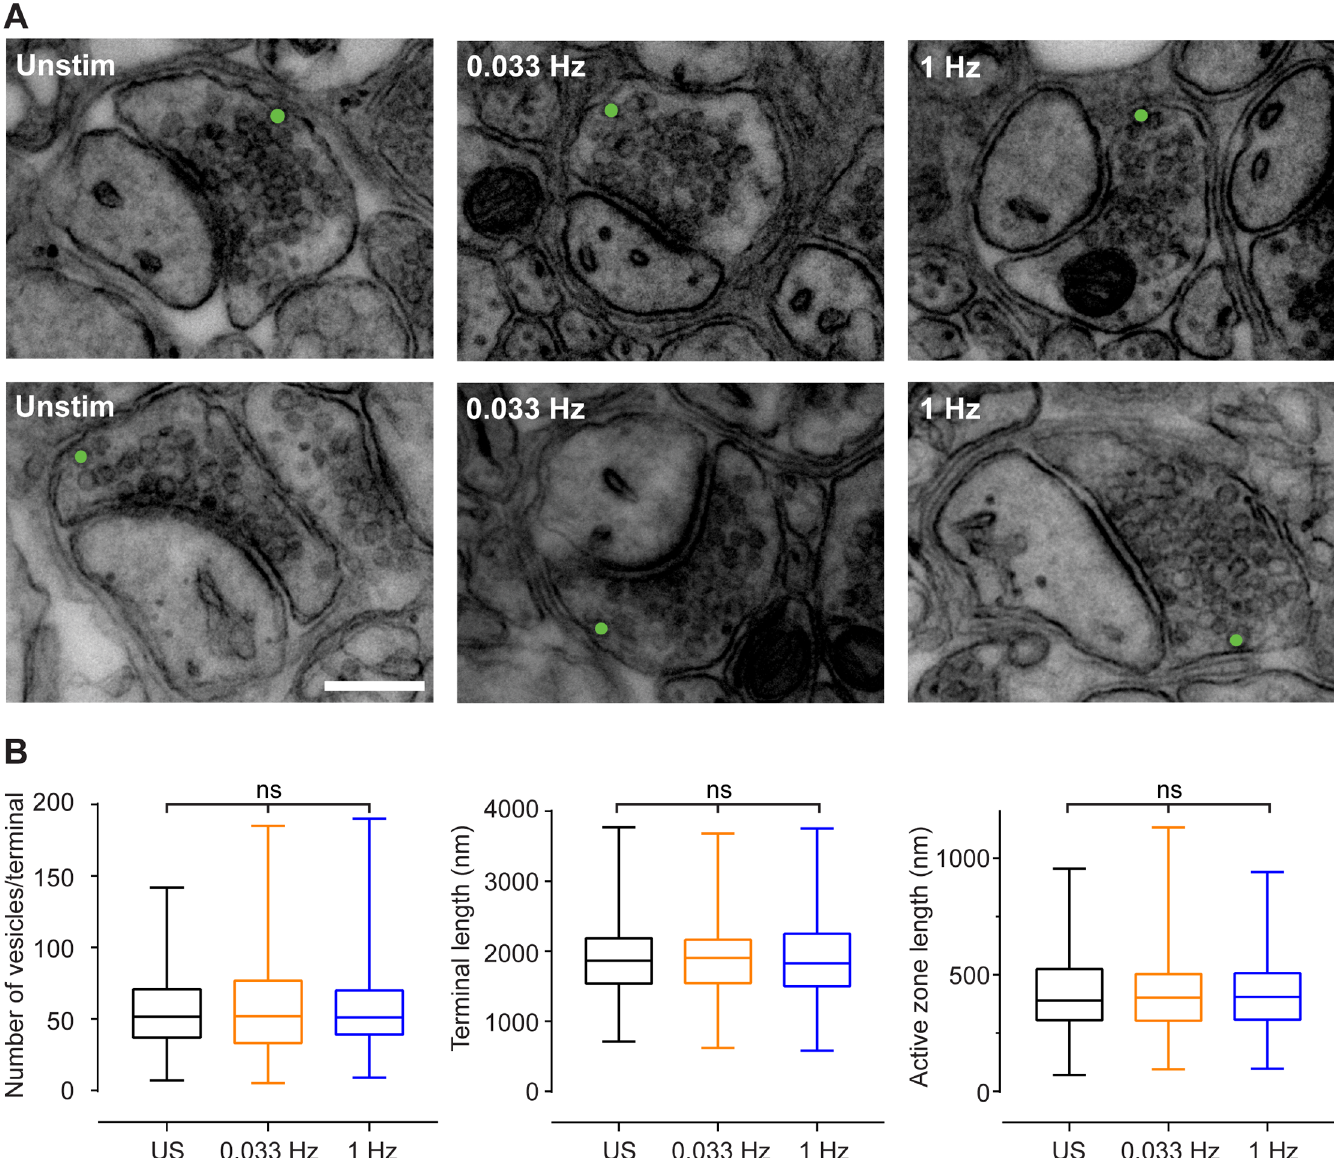
Fig 3. Effect of stimulation on synapse anatomy and presence of putative ectopic vesicles. A) Electron micrographs of synapses from each stimulation condition, with putative ectopic vesicles highlighted in green. Scale bar = 500 nm. B) Box and whisker (min to max) plots of the number of vesicles per terminal (left panel), terminal length (middle panel), and active zone length (right panel) for unstimulated (US, black), 0.033 Hz stimulated (orange) and 1 Hz stimulated (blue) slices. ns p > 0.05, Kruskal-Wallis ANOVA test with Dunn’s correction for multiple